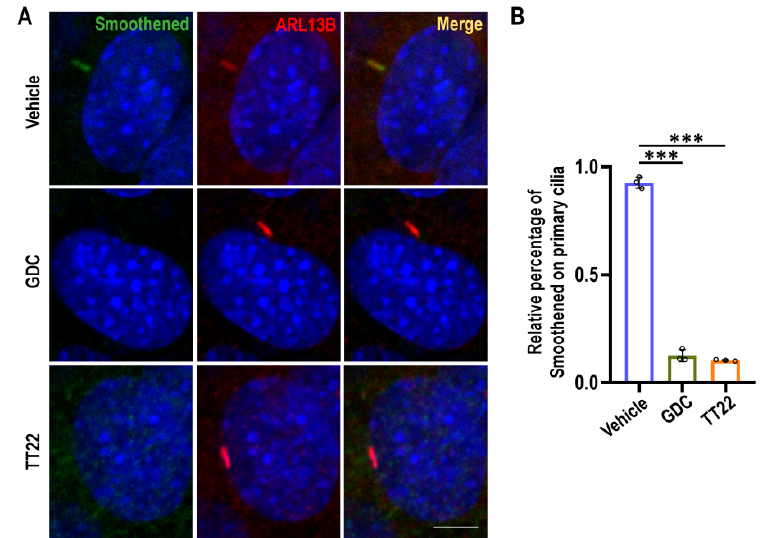
Figure 6. TT22 disrupts the Hh induced Smo accumulation on primary cilia. ( A ) Serum-starved PTCH − / − MEF cells were treated for 24 h at 37 °C with DMSO vehicle, 5 μ M TT22, and 5 μ M GDC-0449 (GDC). Then, the cells were stained with antibodies against Smoothened (green) and ARL13B (red), a marker for primary cilia, and 5 μ M GDC was used as a positive control. ( B ) The percentage of Smo location on primary cilia was quantitated ( n = 100). The statistical data represented the relative percentage of Smo location on primary cilia between different treatments. The scale bar is 5 μ m. All data are means ± SEM (one-way ANOVA). *** p < 0.001.